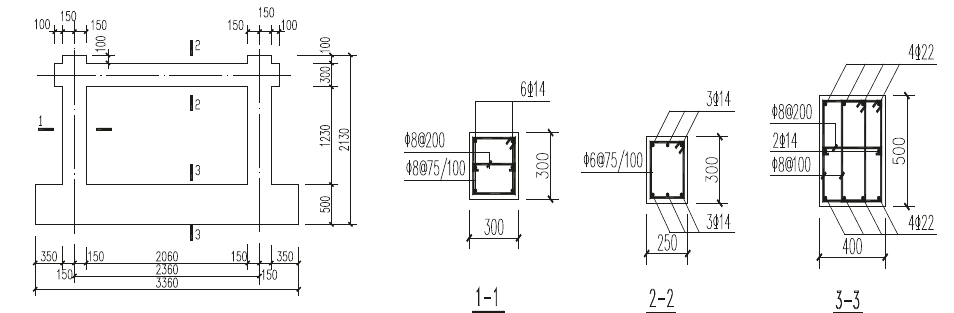
Figure 1: Geometry and reinforcements of specimens.